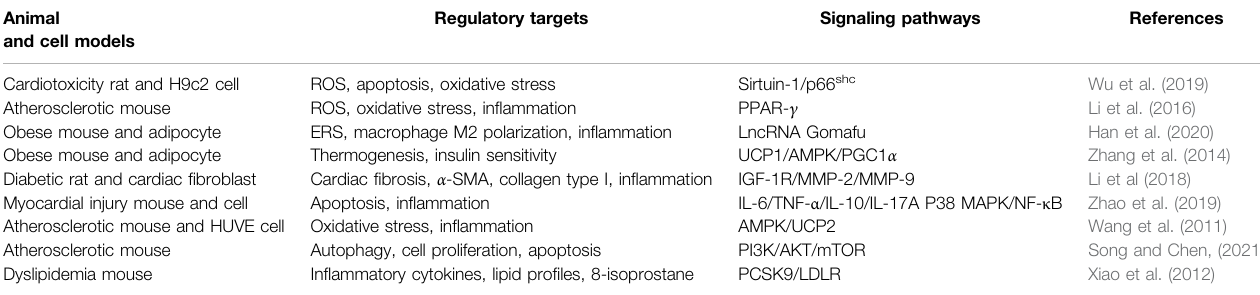
TABLE 1 | Mechanisms of berberine involving oxidative stress and in fl ammation.